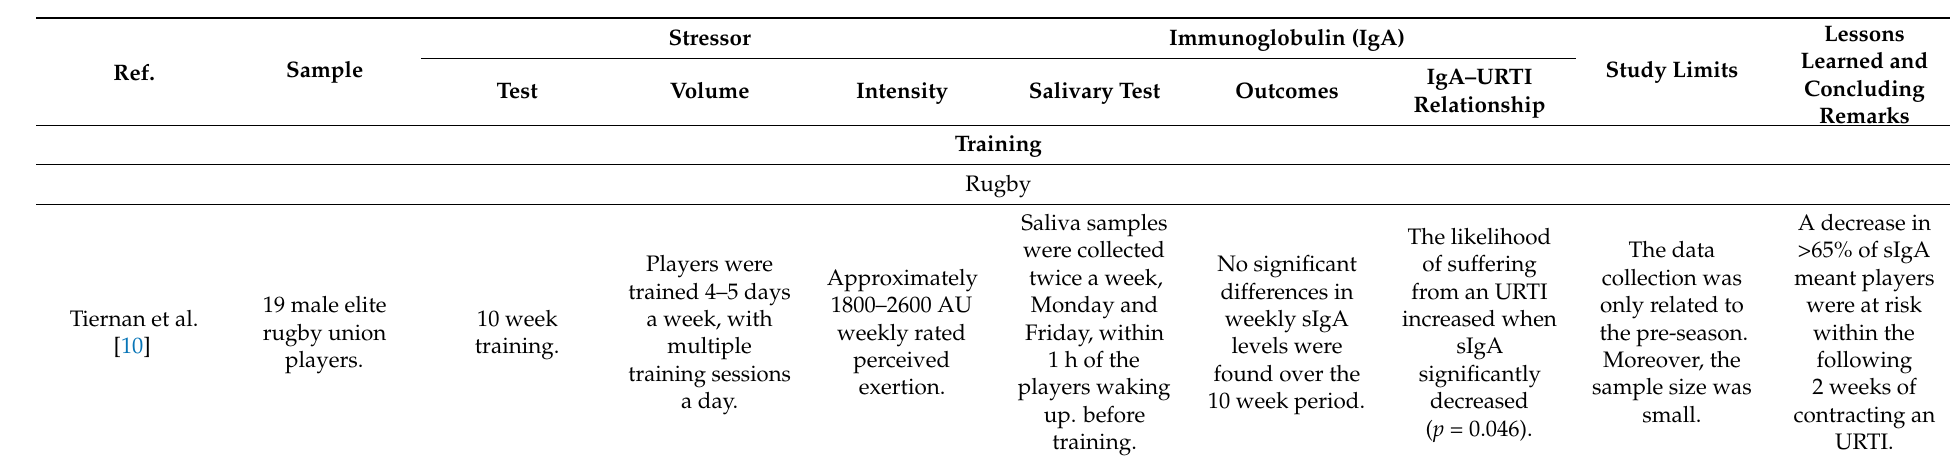
Table 4. Immunoglobulin A responses after training load and its relationship with